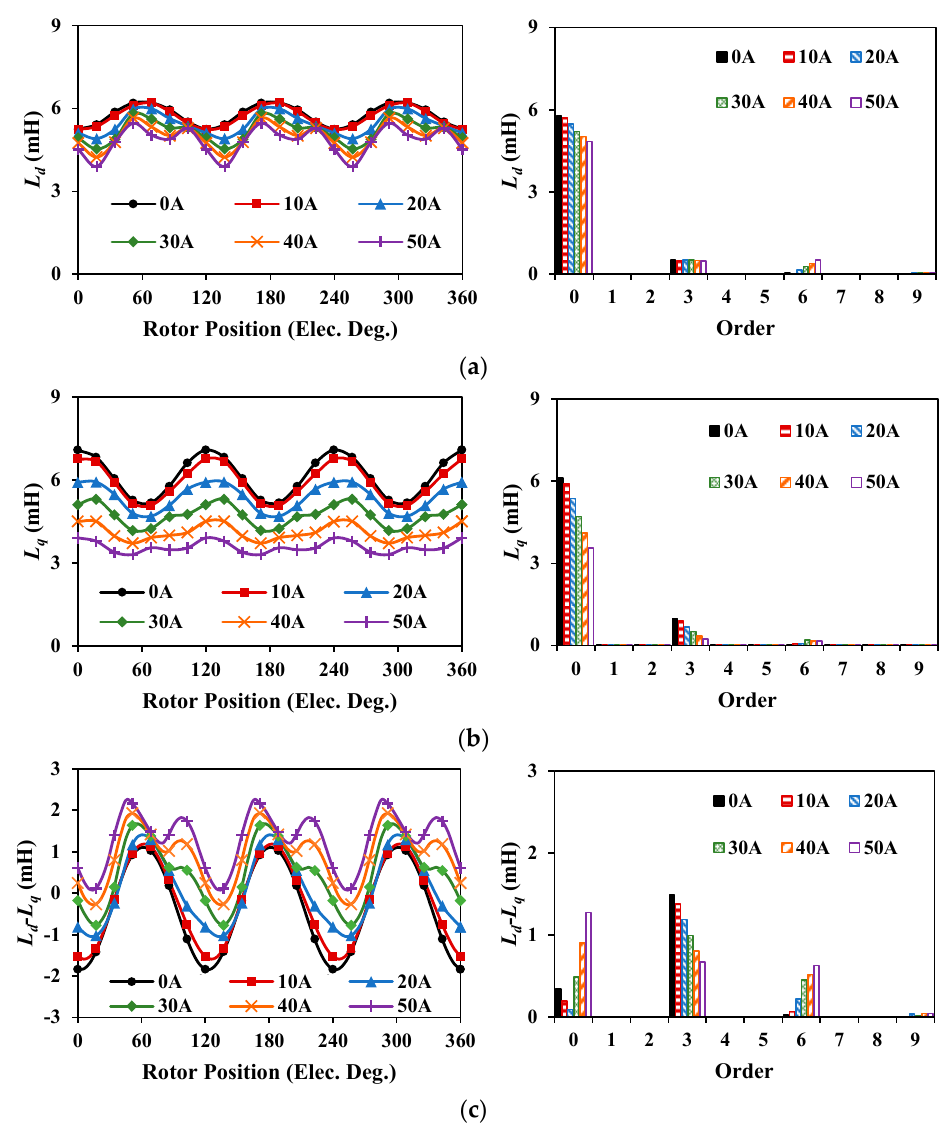
Figure 31. Inductances and spectra of 12s8p-PSCPPM machine. ( a ) L d . ( b ) L q . ( c ) L d - L q .